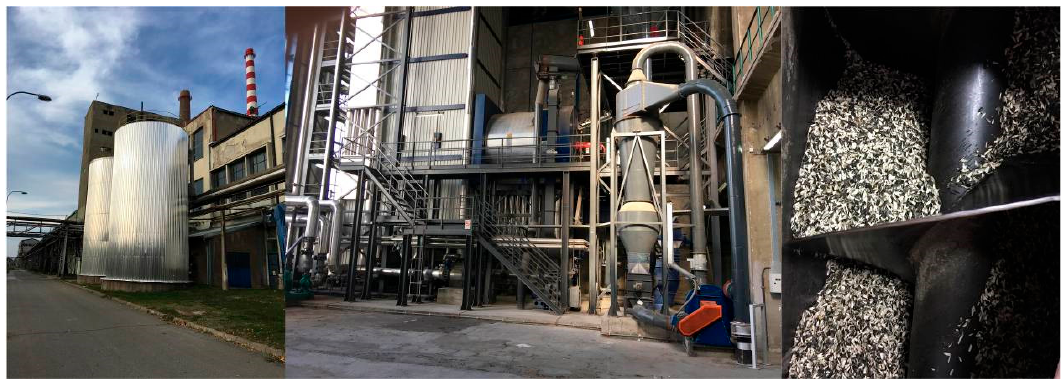
Figure 1. CHP “TE ‐ TO Sremska Mitrovica”. Figure 1. CHP “TE-TO Sremska